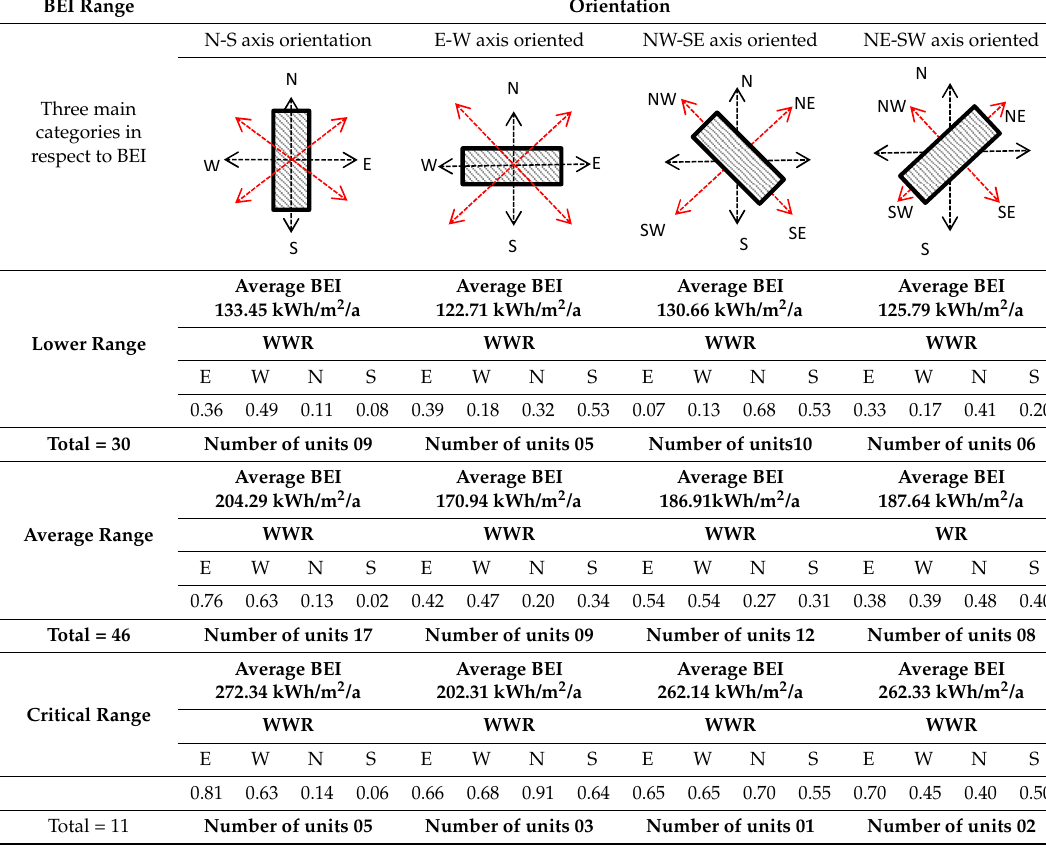
Table 5. Summative results of the analysis showing a nexus between BEIs, window-to-wall ratios (WWRs), and orientations.